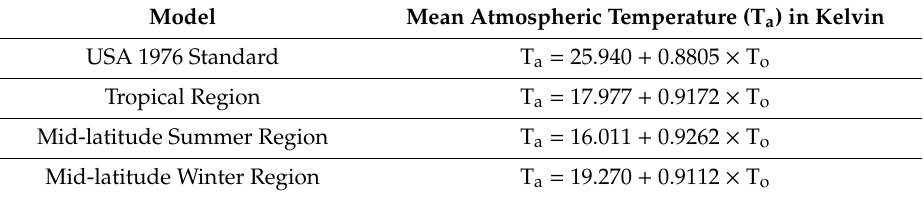
Table A3. The e ff ective mean atmospheric temperature estimation (T a ) using near-surface air temperature (T o